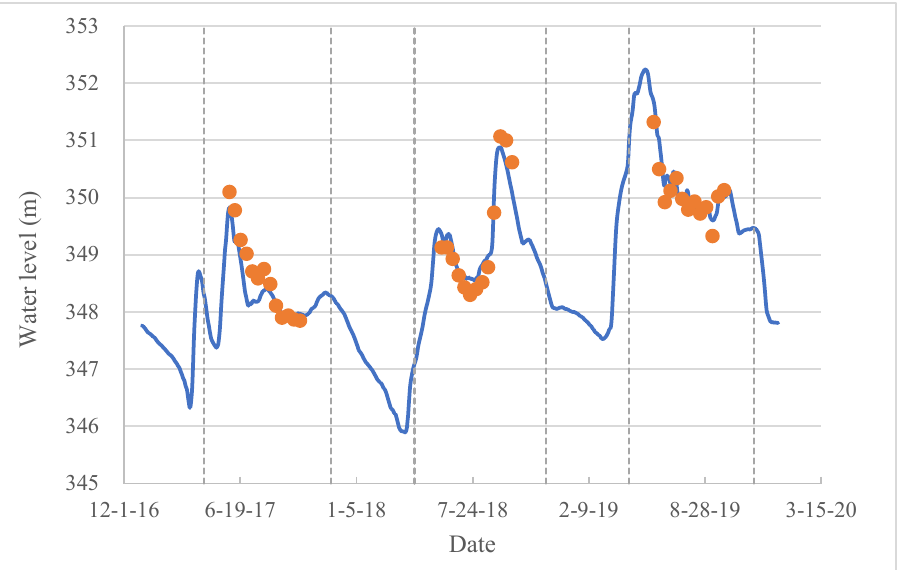
Figure 4. Comparison of the simulation value and measured value of water level in Jingpo Lake. Note: The vertical dotted line in the figure is the boundary between open-water periods and ice- covered periods. The narrow zones represent the ice-covered periods, and the wide zones represent the open-water periods (the same as in Figures 6 and 7).